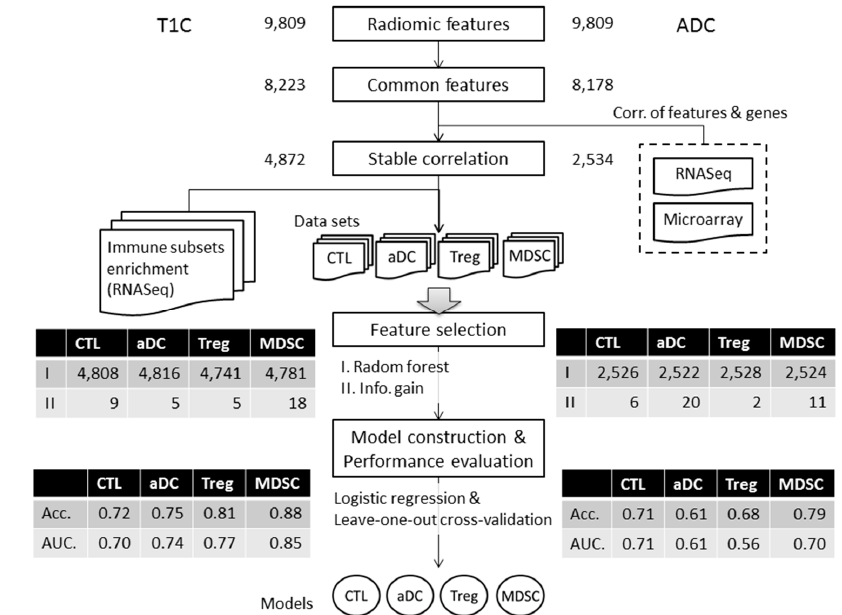
Figure 3. Radiomic-feature filtering for the model construction of four immune cell subsets. Several criteria for filtering the radiomic features of T1 contract enhancement (T1C) and apparent diffusion coefficient (ADC). Numbers of features decreased step by step. Thus, various important features from T1C and ADC for different immune subsets could be used for model construction. Model performance was evaluated with leave-one-out cross-validation.